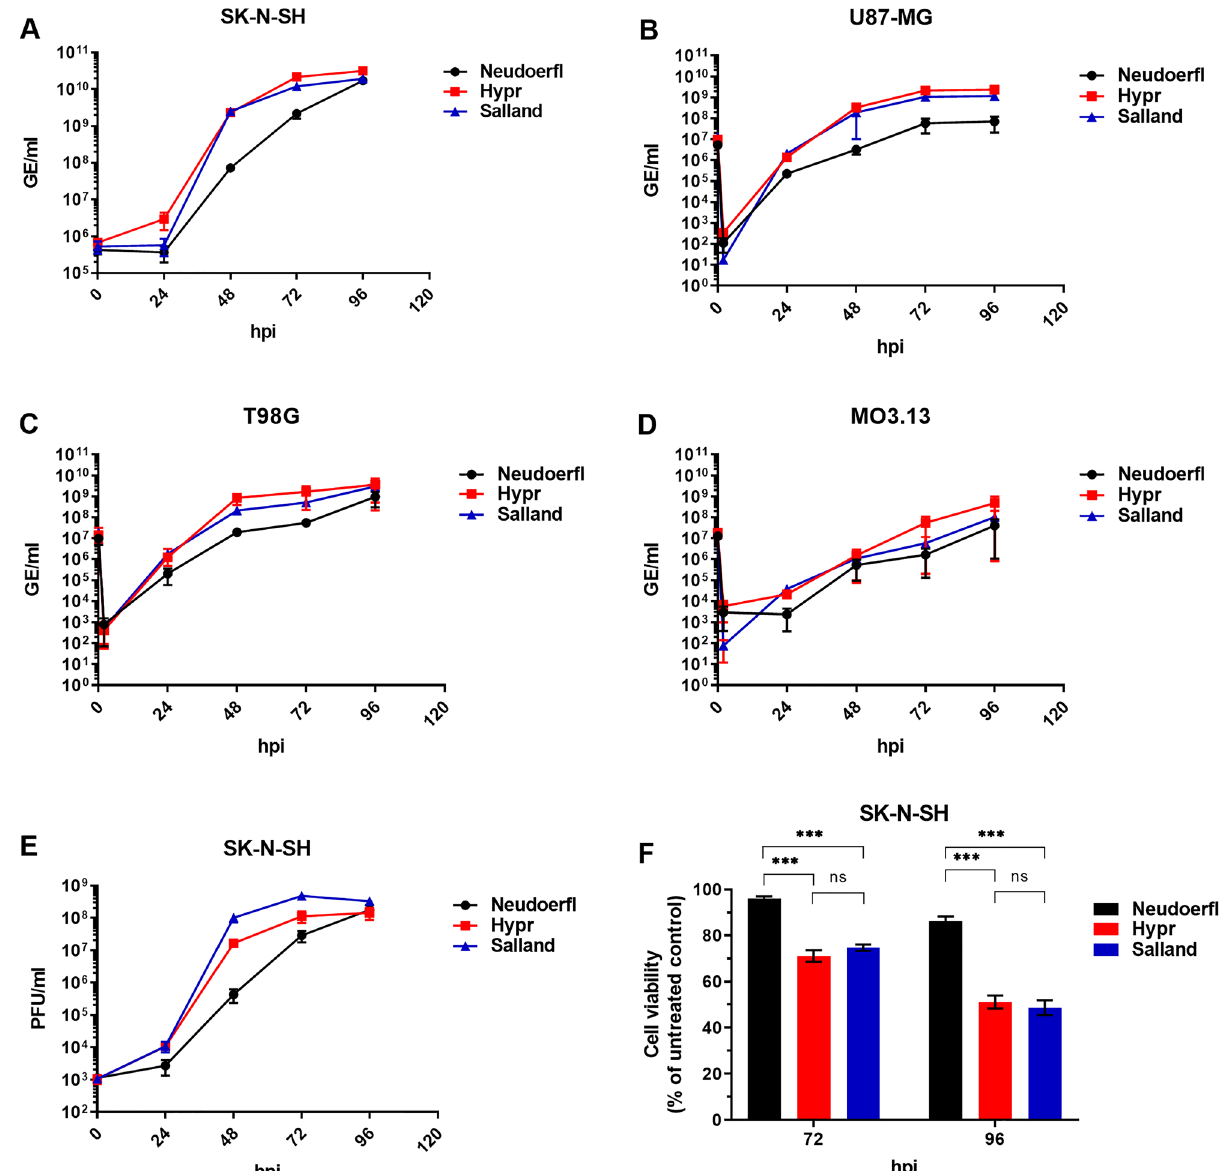
Figure 3. Viral growth kinetics and CPE-induction on neuronal cell lines. SK-N-SH, U87-MG, T98G and MO3.13 cultures were infected with the different TBEV-Eu strains at MOI 0.01 and sampled at indicated timepoints post infection. All values indicate mean ± SEM. GE/ml production on ( A ) SK-N-SH, ( B ) U87-MG, ( C ) T98G and ( D ) MO3.13 as assessed by qRT-PCR. Experiments were performed ( A ) three times in triplicate or ( B – D ) two times in triplicate. ( E ) PFU/ml production on SK-N-SH cells as assessed by plaque assay. Experiments were repeated three times. ( C ) Cell viability of TBEV infected cultures as determined by PrestoBlue assay. Experiments were performed three times in eightfold and normalized to non-infected control cells. Statistical analysis was performed using unpaired students t-test in GraphPad Prism; ***(p ≤ 0.001), ns = non-